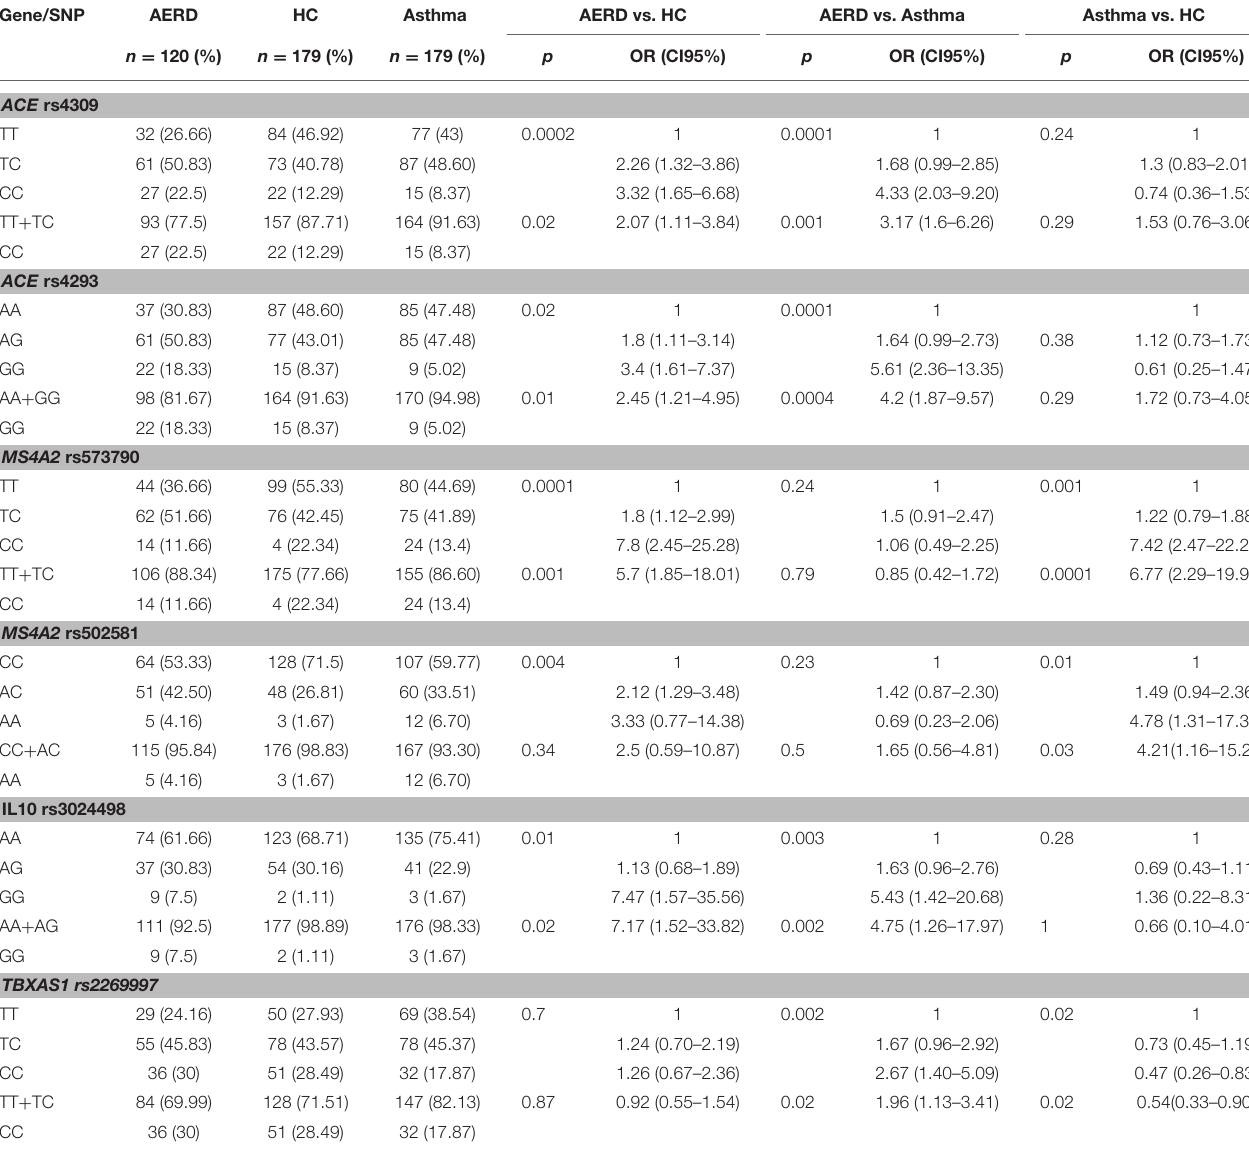
TABLE 5 | Co-dominant and recessive genetic models of principals SNP associated to risk of AERD. Gene/SNP AERD HC Asthma AERD vs. HC AERD vs. Asthma Asthma vs.